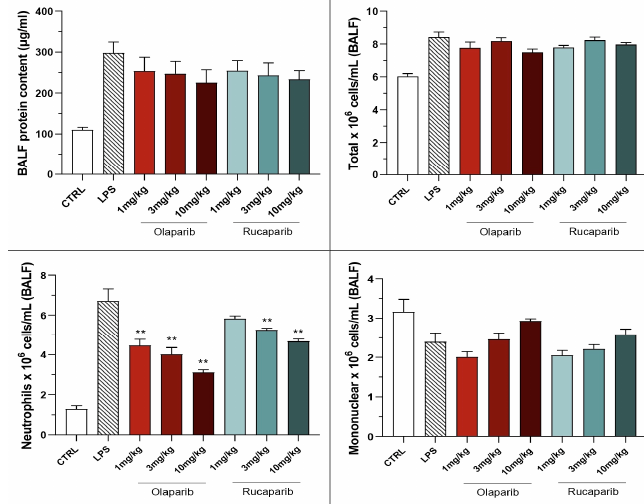
Figure 12. Effect of olaparib and rucaparib on the protein and cell content of bronchoalveolar lavage fluid in a murine model of ALI. C57Bl/6 mice received either PBS (30 µ L) or LPS (50 µ g in 30 µ L PBS) by intratracheal instillation in the absence or presence of various doses (1, 3, or 10 mg/kg) of olaparib or rucaparib. After 24 h, bronchoalveolar lavage fluid was collected, protein content was measured, and inflammatory cell numbers (total cell count as well as neutrophils and mononuclear cells) were quantified. ** p < 0.01 indicates the beneficial effect of the PARP inhibitors tested in LPS-treated animals. Data are shown as mean ± SEM, n = 8–12/group.